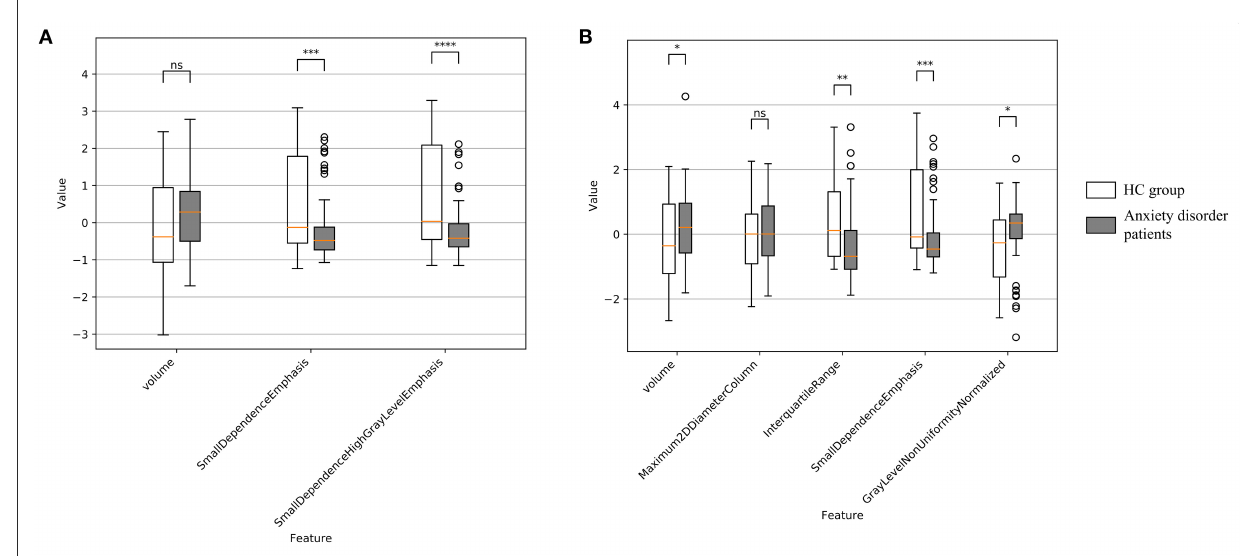
FIGURE3 Feature distribution and group-wise comparison results on selected radiomics features of Anxiety disorder vs. HC task. (A) Results of left amygdala radiomics features; (B) results of right amygdala radiomics features. Points are outliers in the box plot. NS, not significant; * p ≤ 0.05; ** p ≤ 0.01; *** p ≤ 0.001; **** p ≤